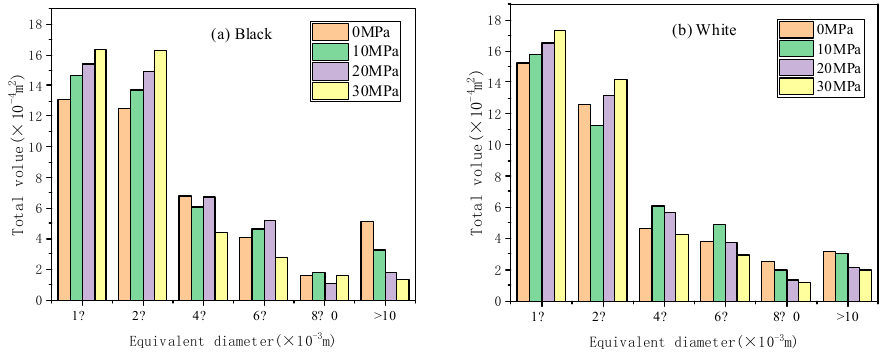
Figure 18. Fragment size